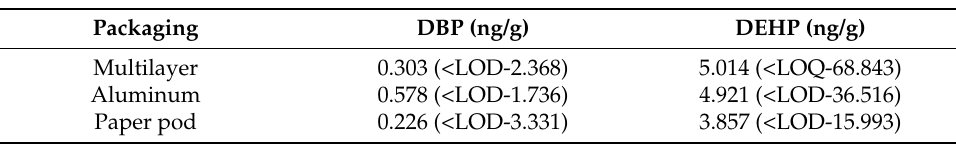
Table 1. Concentrations (ng/g) of DBP and DEHP expressed as median (min-max) values in coffee powder packed using different